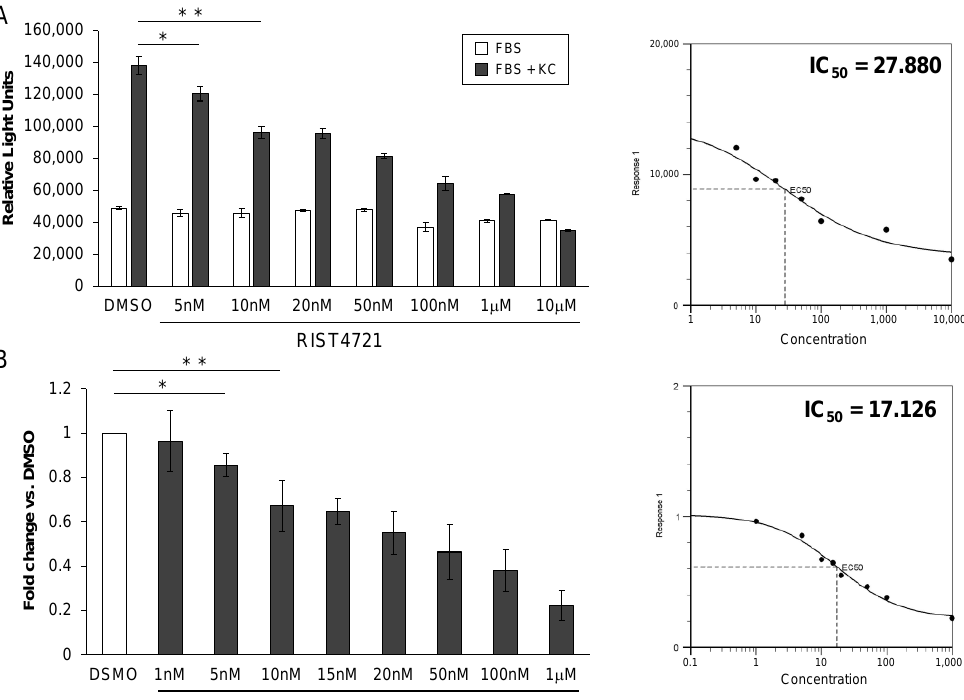
Figure 4. Broad-range concentration effects of RIST4721 on neutrophil chemotaxis identifies IC50 values. ( A ) Graphed are chemotaxis responses of neutrophils to a broad spectrum of RIST4721 concentrations ranging from 5 nM to 10 µ M, which reveals MIC is near 5 nM but maximal inhibition (i.e., responses are equivalent to FBS alone) is provided by 10 µ M; these values were then used to calculate the indicated IC 50 ( right panel). ( B ) Compiled fold changes of responses compared to DMSO are shown, which were then used to also calculate an IC 50 value, identified as ~17 nM. Data shown are averages ± SD from triplicate tests per assay. * p < 0.05, ** p < 0.001.